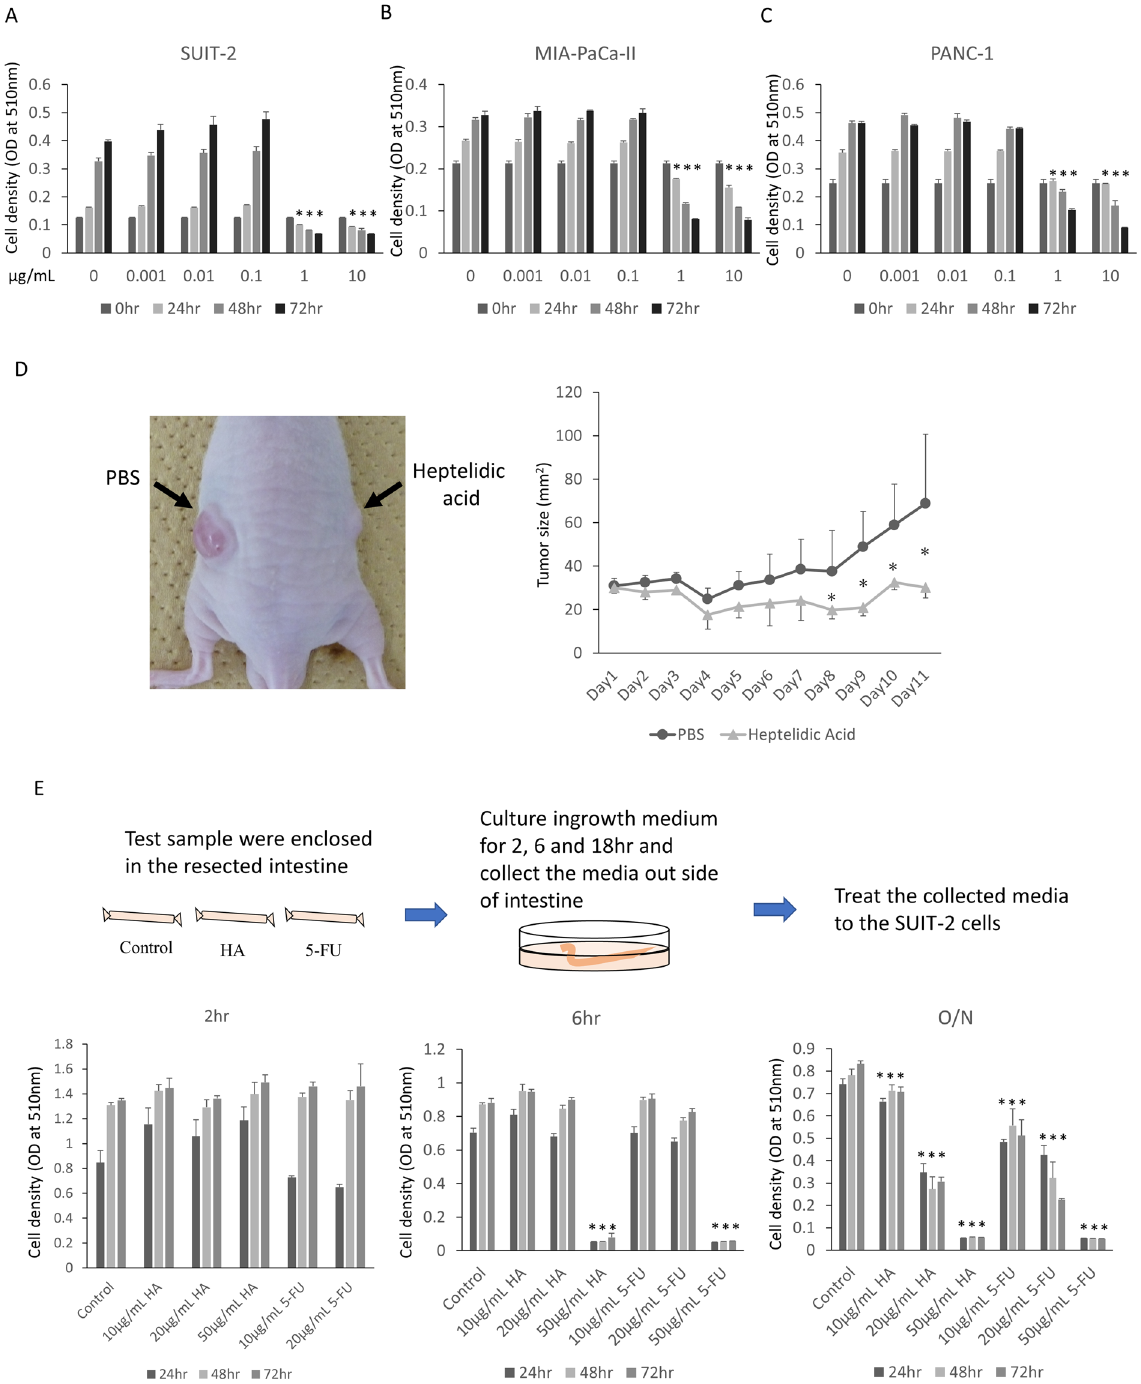
Figure 4. Heptelidic acid showed the anti-tumor effect in vitro and in vivo. The SRB assay showed that heptelidic acid exerted a growth-suppression effect against SUIT-2 ( A ), MIA-PaCa-II ( B ) and PANC-1 ( C ) cells in a concentration-dependent manner. SUIT-2 cells were transplanted into nude mice, and 10 μg of heptelidic acid was injected daily to the tumor. The growth of the tumor was significantly inhibited by treatment with heptelidic acid ( D ). Heptelidic acid or 5-FU was injected into the small intestine of mice and incubated in culture media for 2, 6 and 18 h. The SRB assay showed the anti-tumor effect of the media collected from outside the intestine enclosed with heptelidic acid or 5-FU ( E ). The error bars show the standard deviation (S.D.) ( A , B , C , E ; n = 3, D ; n =